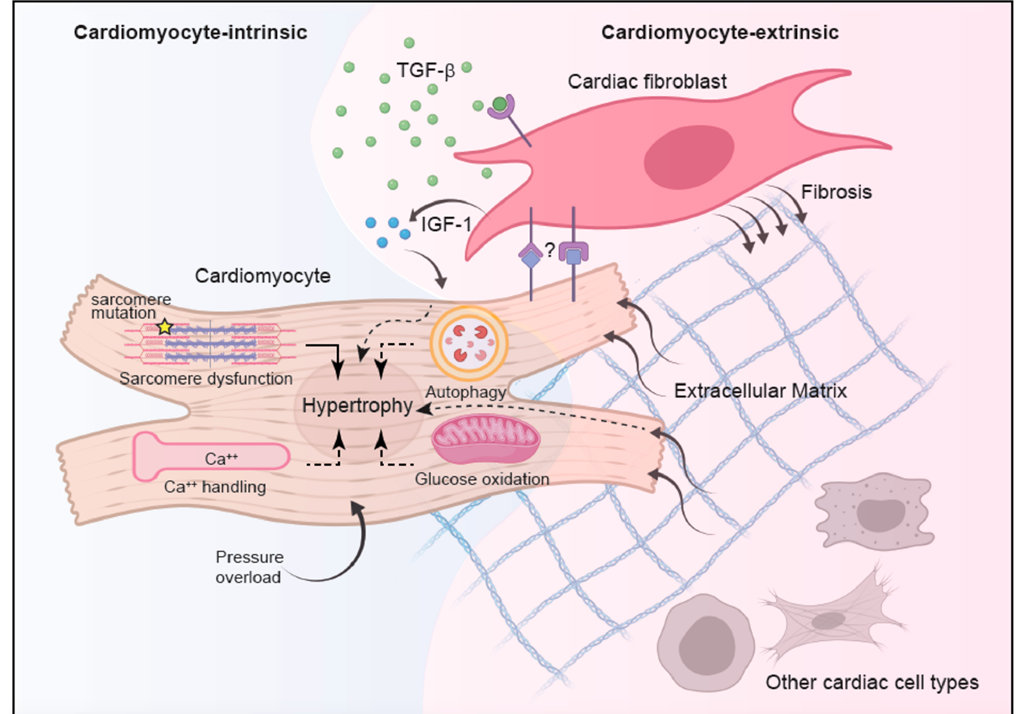
Figure 1. Integrated model of HCM pathogenesis. HCM pathogenesis involves complex interplay between cell-intrinsic processes and intercellular communications. While genetic mutations in sarcomere proteins represent the most well-established cause of cardiomyocyte hypertrophy, alterations in other cellular processes, such as enhanced calcium signaling, reduced autophagy, and suppressed glucose oxidation in response to pressure overload, have also been implicated. With the advance of single-cell transcriptome analysis, better characterization of other non-cardiomyocyte cell types revealed complex intercellular communications during homeostasis and disease states, implying a contribution from non-cardiomyocytes in propagating HCM. In particular, cardiac fibroblasts have been implicated in promoting cardiac fibrosis during HCM in a TGF- β -dependent manner although the source of TGF- β is still unknown. The TGF- β -activated cardiac fibroblasts in turn acquire hypertrophy-inducing capacity and in conjunction with altered extracellular matrix can modify cardiomyocyte growth and function in part through the secretion of IGF-1. Recent data also implicated a role of direct interaction between cardiac fibroblasts and cardiomyocytes in HCM pathogenesis, with the contribution from other cardiac cells remaining